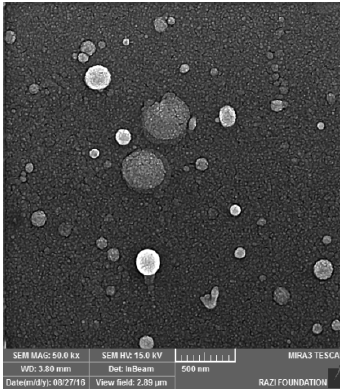
Fig. 4 SEM image of the nanostructured SiO 2 film prepared in this work.